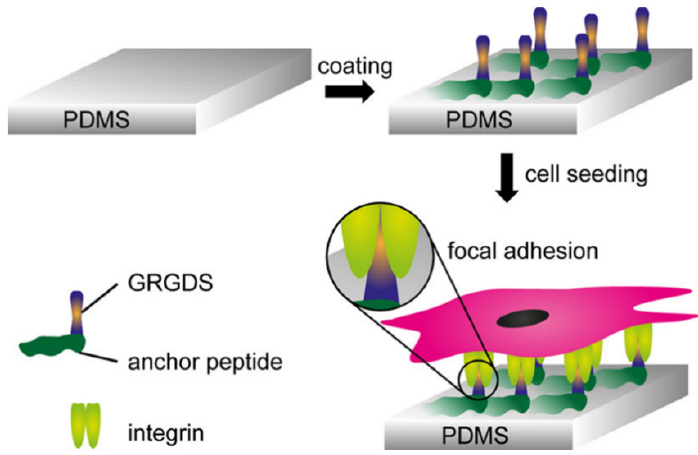
Figure 6. Schematic illustration of polydimethylsiloxane (PDMS) coating using engineered anchor peptides fused to the cell-adhesive peptide sequence (glycine-arginine-glycine-aspartateserine, GRGDS). (Reprinted with permission from [63] Copyright (2019), American Chemical Society).